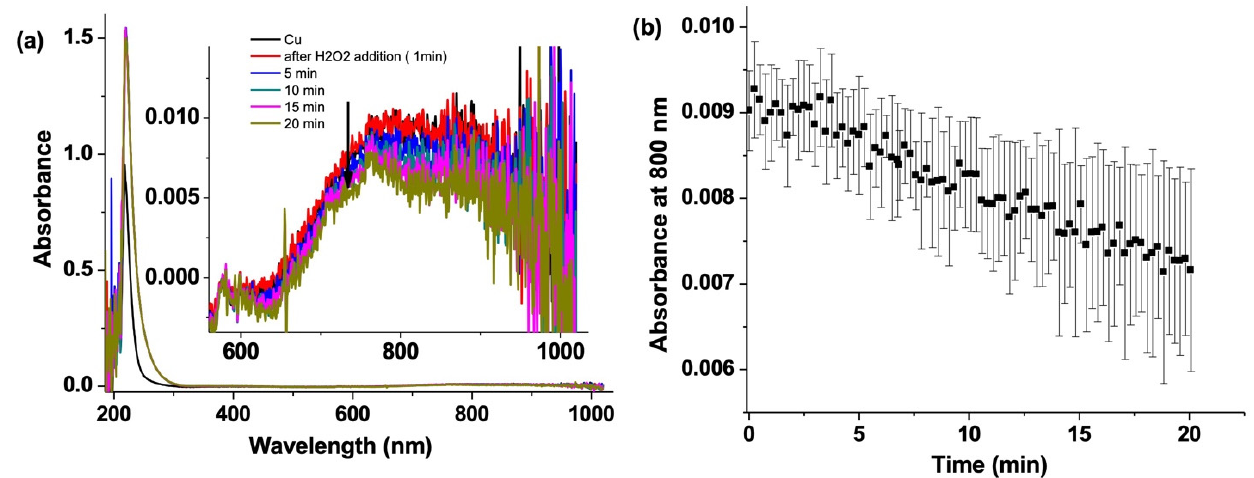
Figure 4. ( a ) UV–Vis absorption spectra of CuSO 4 (1 mM) (black) and after addition of H 2 O 2 and ( b ) its kinetic trace plotted at 800 nm over 20 min.